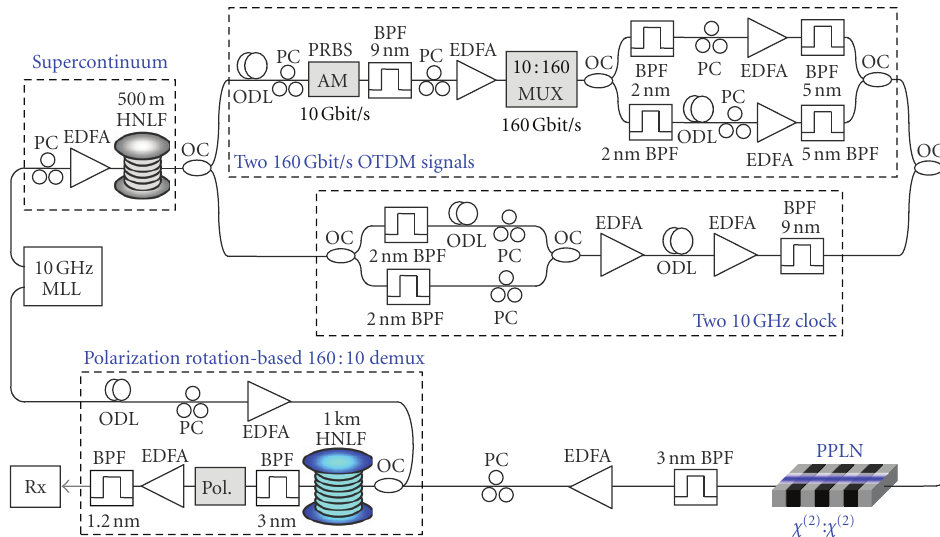
Figure 8: Experimental setup for single-PPLN-based 10 Gbit/s tributary channel exchange between two 160Gbit/s signals. MLL: mode-